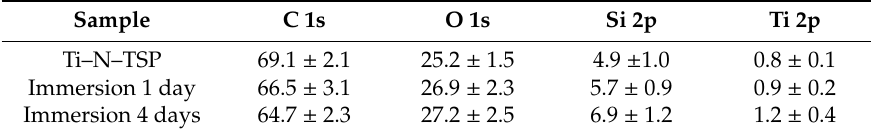
Table 2. Chemical composition (atomic percentage (%), mean ± standard deviation (SD)).